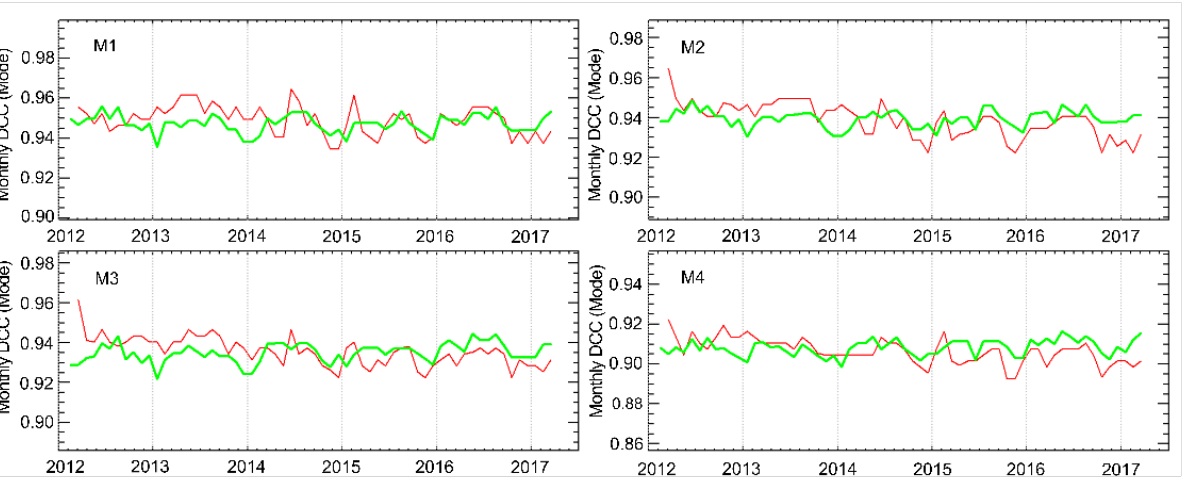
Figure 10. Suomi NPP VIIRS bands’ M1–M4 monthly DCC reflectance time series before (red color, operational) and after (green color) recalibration.